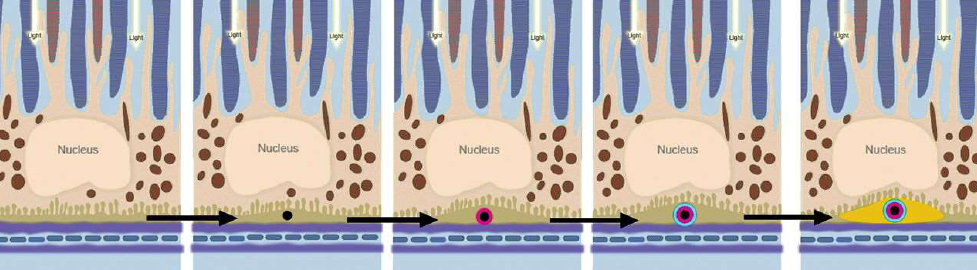
Figure 2. Model of sub-RPE deposit formation. Graphical overview of the proposed mechanism for the growth of sub-RPE deposits containing hydroxyapatite (reproduced with permission from Thompson et al. [89]). Micrometer-sized, cholesterol-containing extracellular lipid droplets (black) provide a site of hydroxyapatite (HAP) (magenta) precipitation. Deposit growth follows, with the binding of various proteins (blue) to the surface of HAP, facilitating a self-driven oligomerization process forming the macroscopic sub-RPE deposits (yellow). The brown particles within the RPE represent melanocytes.